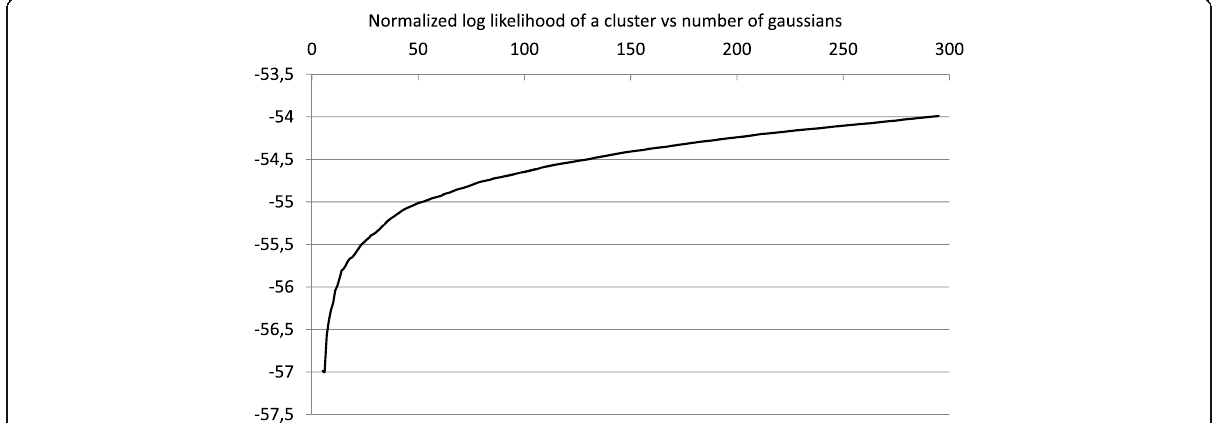
Fig. 7 Normalized log-likelihood of a cluster versus the number of Gaussians used to train it. The likelihood improves asymptotically and very slightly to a maximum number independent of the number of